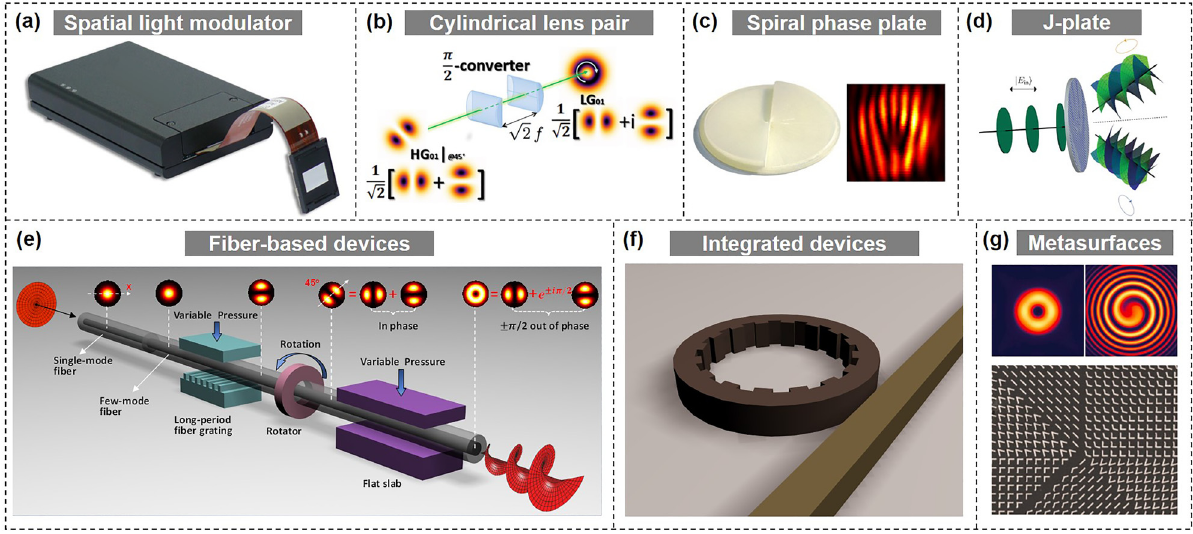
Figure2: TypicalOAMgenerationtechniques(spatiallightmodulator[SLM][20,39],cylindricallenspair[35],spiralphaseplate[45],J-plate[47], fi ber-based devices [51], photonic integrated devices [53], metasurfaces [55]). Reprint permission obtained from [20, 35, 39, 45, 47, 51, 53,